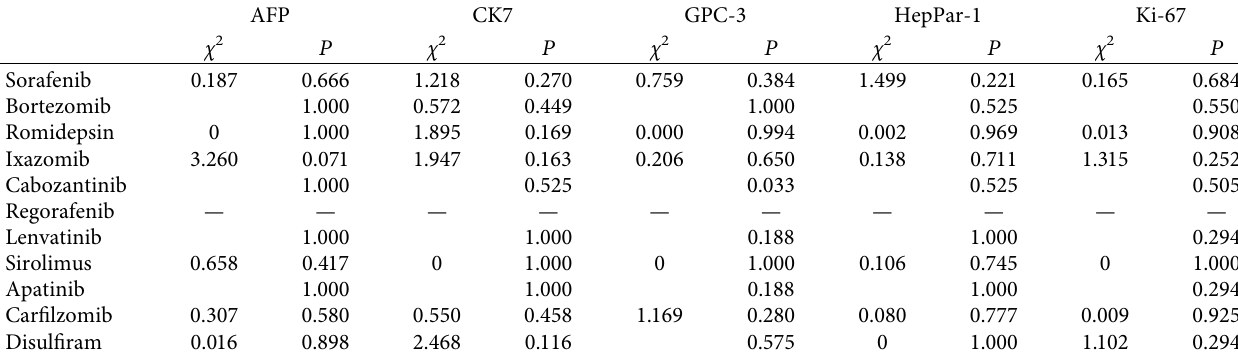
Table 5: Relationships between immunohistochemistry markers and sensitivity to targeted and other drugs.